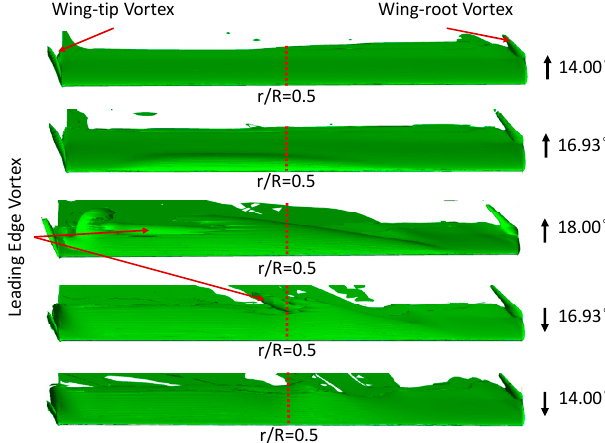
Figure 10. Equal ‐ vorticity surfaces at different AoAs.